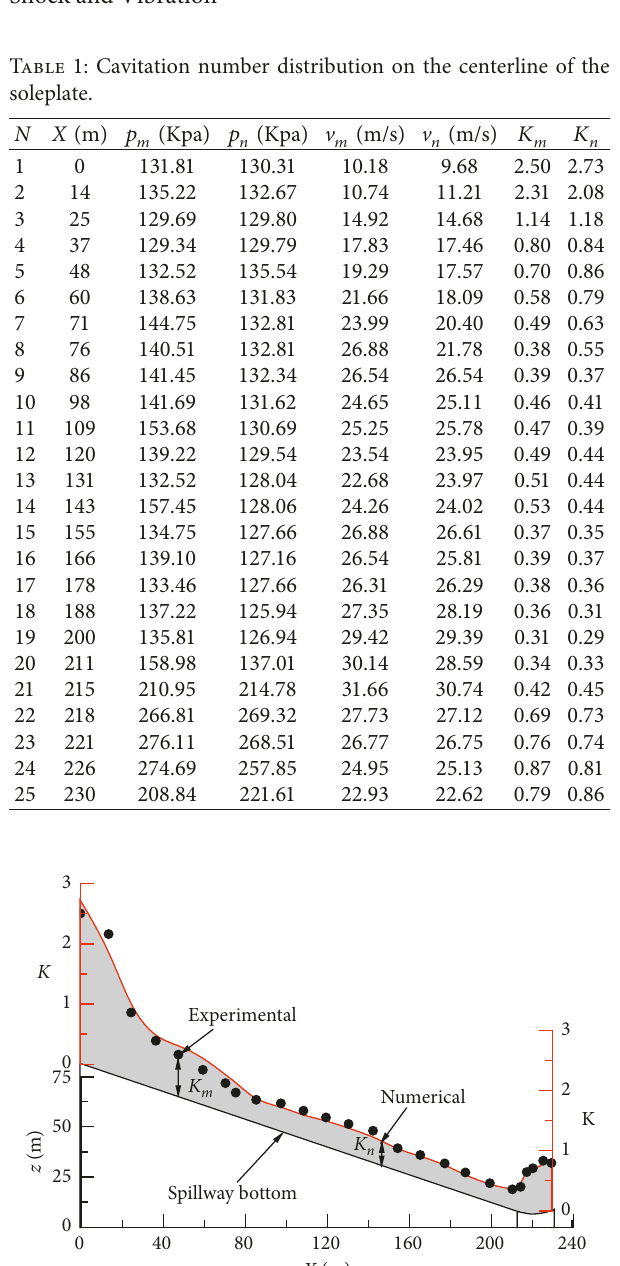
Figure 12: Cavitation number distribution in the centerline of the chute.